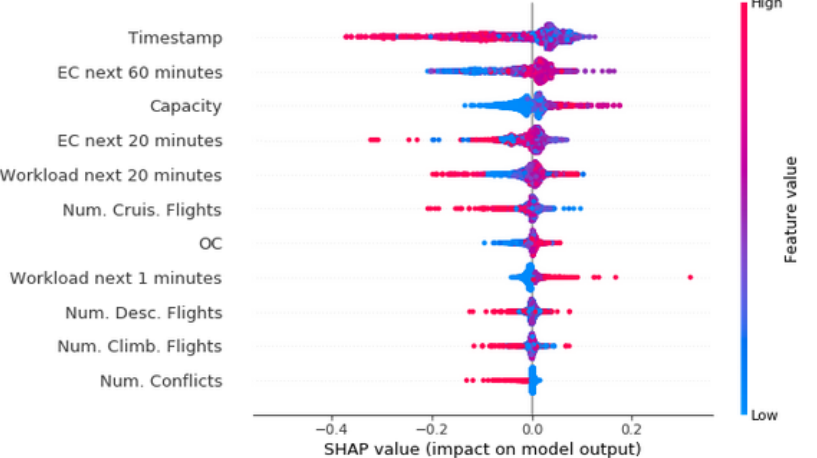
Figure 19. SHAP values for the RNN-based model. From top to bottom, the more relevant input features. The color map indicates how larger or smaller the value of the input feature was, and the location in the corresponding horizontal line represents the activation it generated. The zero in the X-axis represents no contribution to the